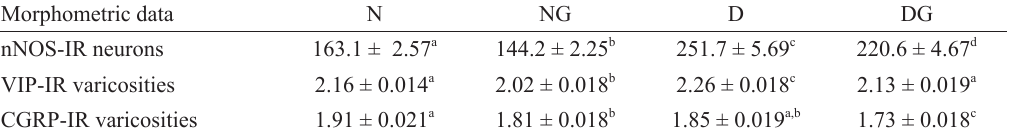
Average area in µm 2 of myenteric neuronal cell bodies (nNOS-IR) and myenteric varicosities (VIP-IR and CGRP-IR) in normoglycemics (group N), normoglycemics supplemented with L-glutamine (group